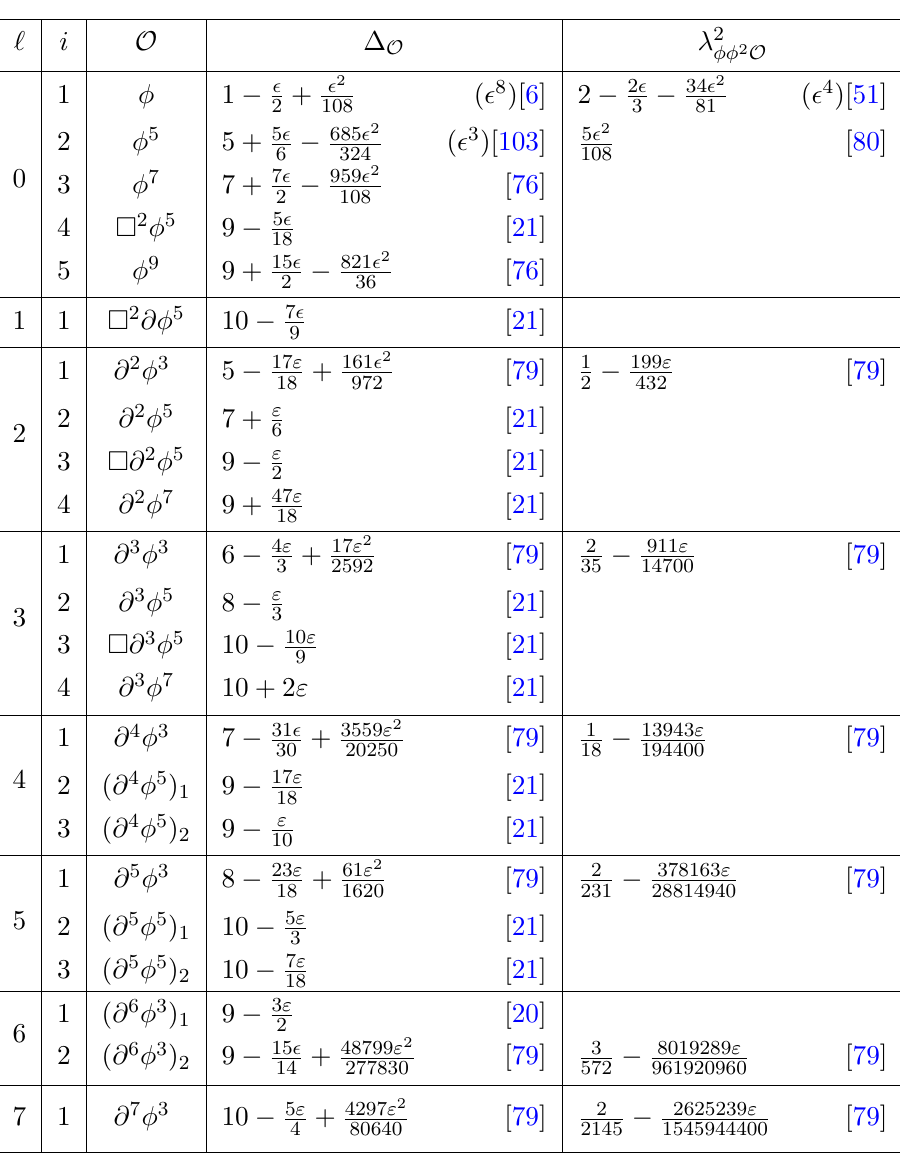
Table 5 . Perturbative results for Z 2 -odd operators with ∆ 6 10